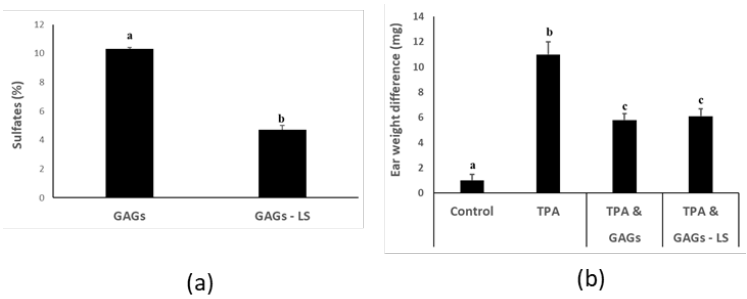
Figure 5. GAGs from sea cucumber ( I. badionotus ) with sulfate levels of 4.5% or above have similar anti-inflammatory properties. ( a ) The sulfate content of freshly-isolated GAGs used in analyses was quantified. The GAGs—LS were derived from the same sample but were reconstituted and lyophilized at least 3 times prior to sulfate analysis. ( b ) Differences in ear weights (right-left) in mouse ears exposed to vehicle alone (left ear), or inflammatory agent TPA followed by GAGs or GAGs—LS [low sulfate] (right ear). For each figure, n ≥ 4 per group and values with distinct superscripts differ significantly from each other ( p ≤ 0.05).